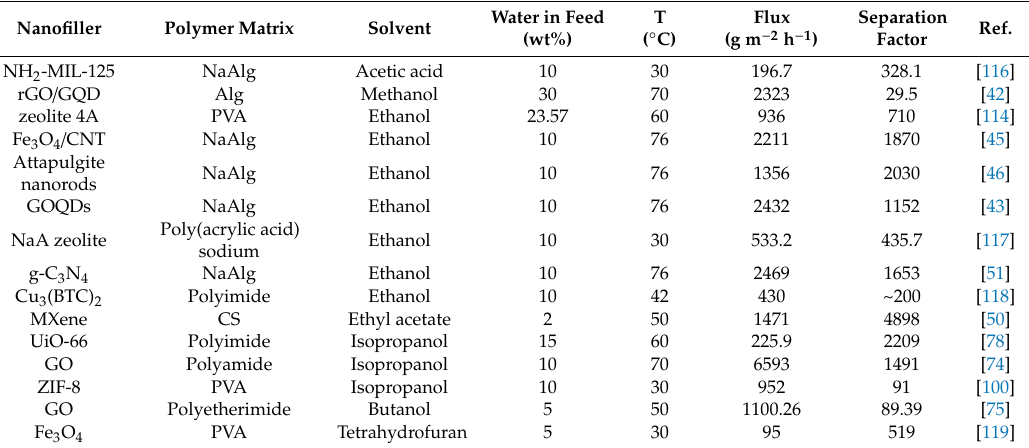
Table 2. Typical nanofillers used in dehydration of